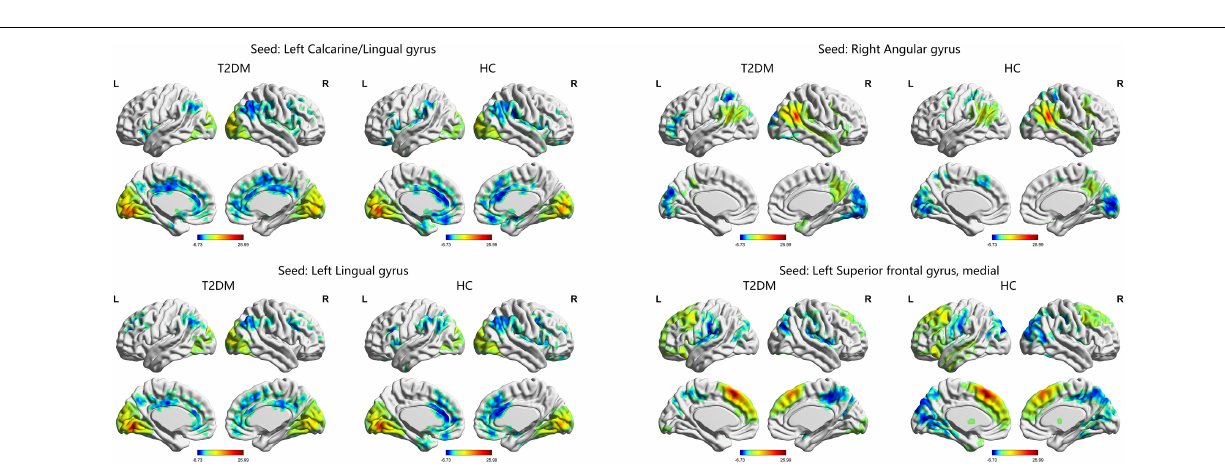
FIGURE 2 | The distribution of functional connectivity of each seed region in the T2DM group and HC group. Color scale denotes the t -value. L, left; R, right. TABLE 3 | Brain regions with significant differences in FCD between the T2DM group and HC group. Brodmann Peak MNI coordinates T -values